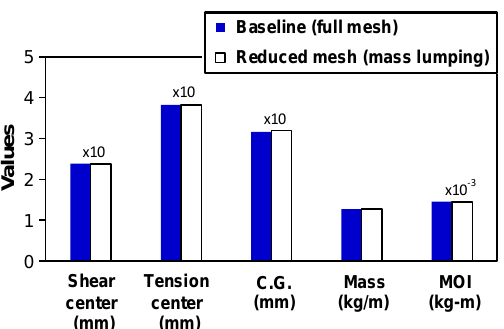
Figure 7. FE mesh of a blade airfoil section (U6) incorporating sensor cables. ( a ) Full FE mesh with individual cables. ( b ) Reduced FE mesh with lumped mass of cables.